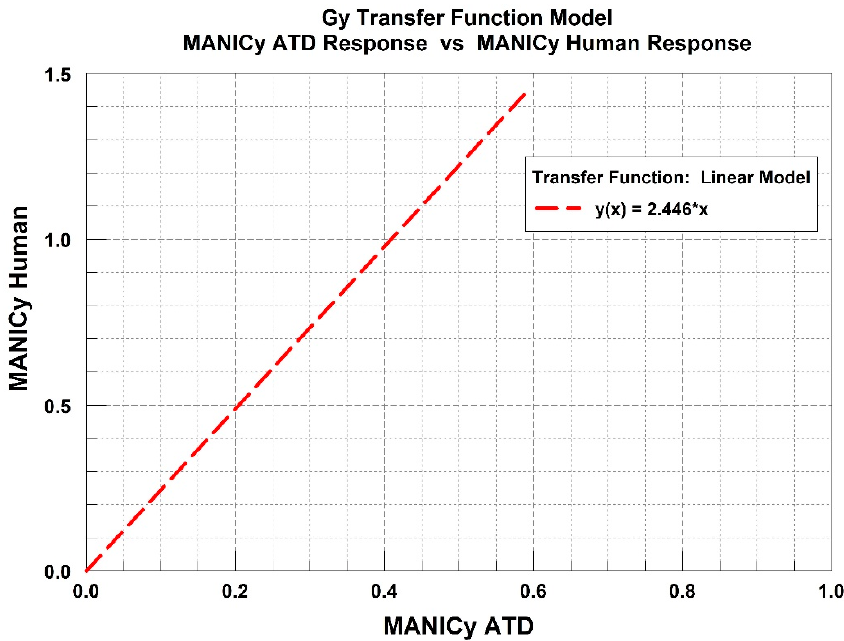
Figure 12. Transfer function relating ATD MANICy to the human MANICy. Transfer function is a linear regression model created with ATD MANICy and Human MANICy data generated from the ATD and Human linear regression models (Figure 11) as a function of selected impact acceleration values For example, at around 10 G, the ATD MANICy is 0.2, and the Human MANICy is 0.5, and the data are plotted against each other.